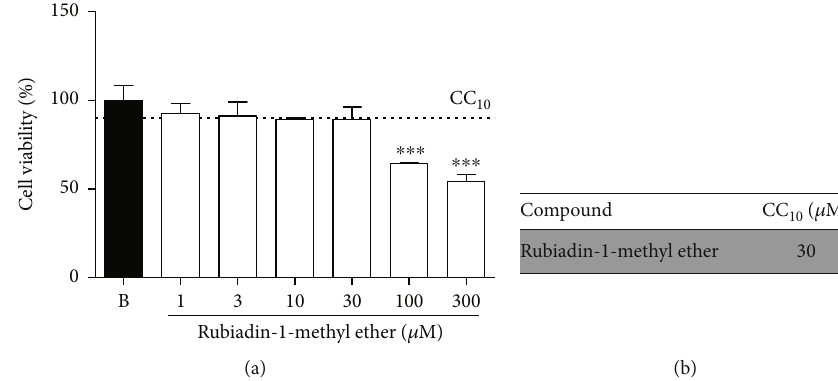
Figure 2: Evaluation of Rubiadin-1-methyl ether cytotoxicity (RAW 264.7) (a) and calculated CC with vehicle and stimulated with PBS; Rubiadin-1-methyl ether: cells pretreated with Rubiadin-1-methyl ether at doses at 1 to 300 μ M. Each bar represents the average survival of the macrophages in independent experiments ± S : D . ( n = 3 ). ∗∗∗ P < 0 : 001